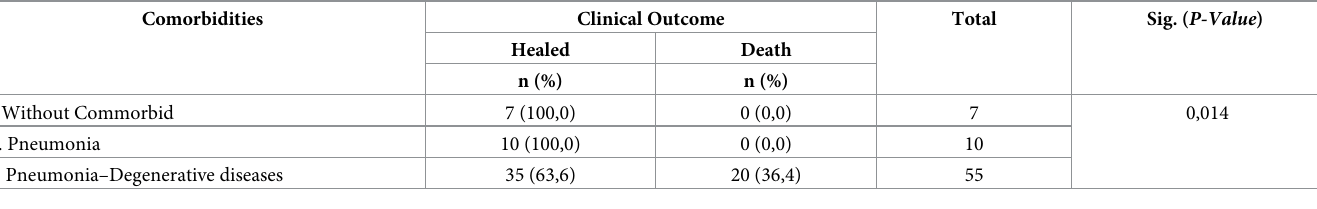
Table 4. Correlation between comorbidities and clinical